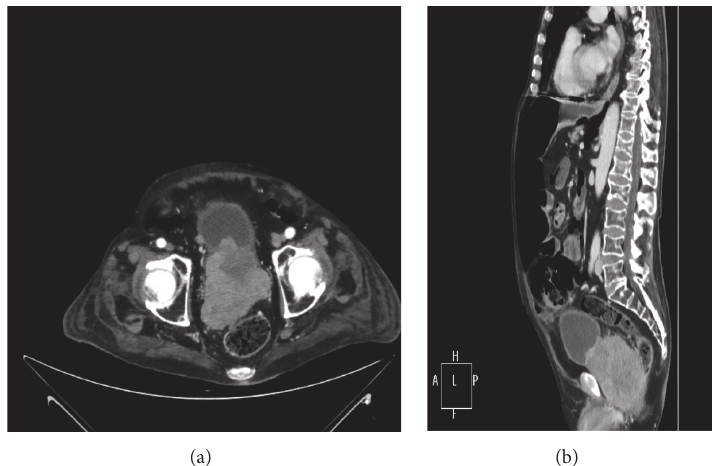
Figure 1: Computed tomography (CT) images, axial (a) and coronal (b), of the pelvis showing a huge mass involving bladder and rectum.